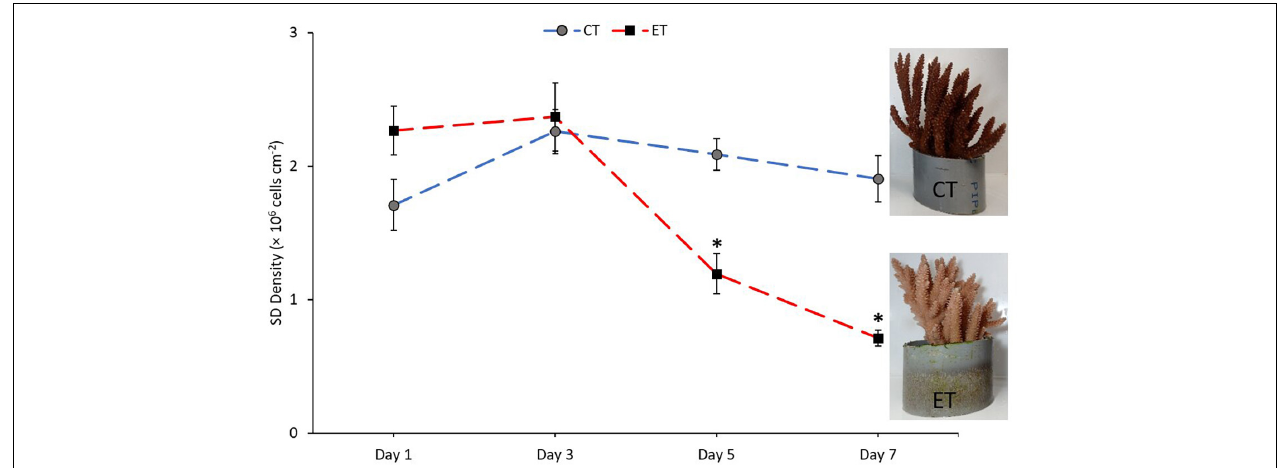
FIGURE 4 | Mean densities of Symbiodiniaceae in CT and ET throughout the experimental period with the images of samples taken from ET and CT during the end of experiment. All data points are mean ± SE ( n = 9). Asterisk represent significant difference ( p < 0.05).